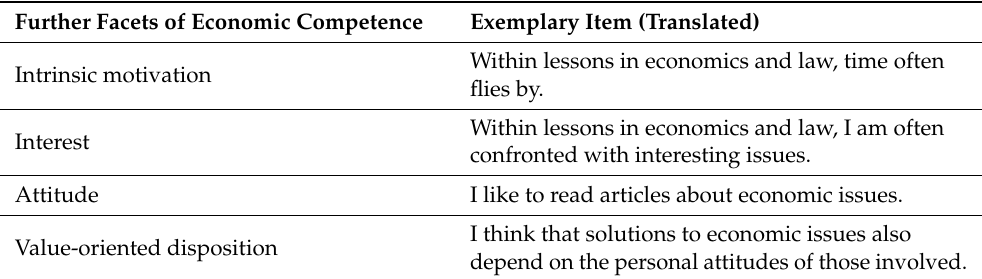
Table 5. Exemplary items for the further facets of economic